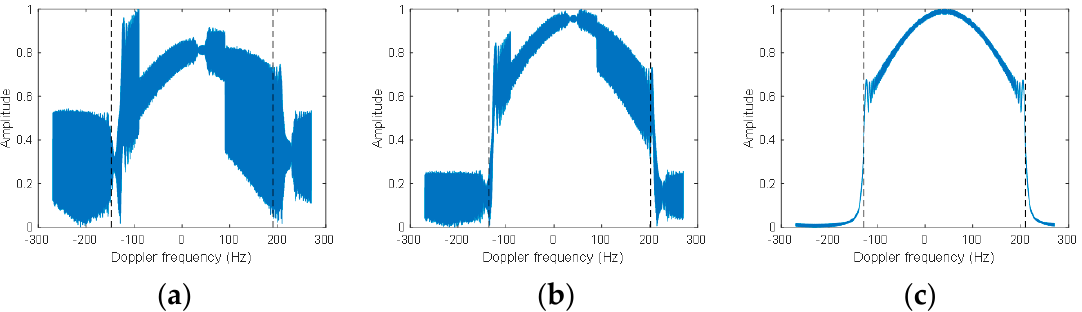
Figure 10. Reconstructed Doppler spectra via different slant range velocities for reconstruction in the band - limited case, while the actual target slant range velocity is 10 m/s. ( a ) The slant range velocity for reconstruction is 5 m/s. ( b ) The slant range velocity for reconstruction is 8 m/s. ( c ) The slant range velocity for reconstruction is 10 m/s.